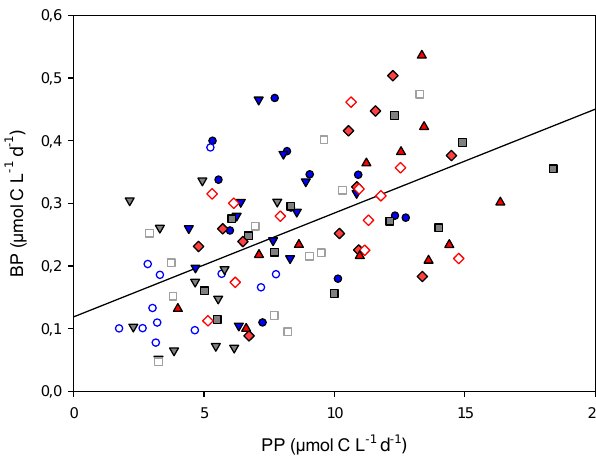
Fig. 12. Relationship between bacterial biomass production (BP) and primary production (PP) in the mesocosm samples was highly significant ( p < 0.001, n = 108) for the total period of the experi- ment (day 4–day 28).